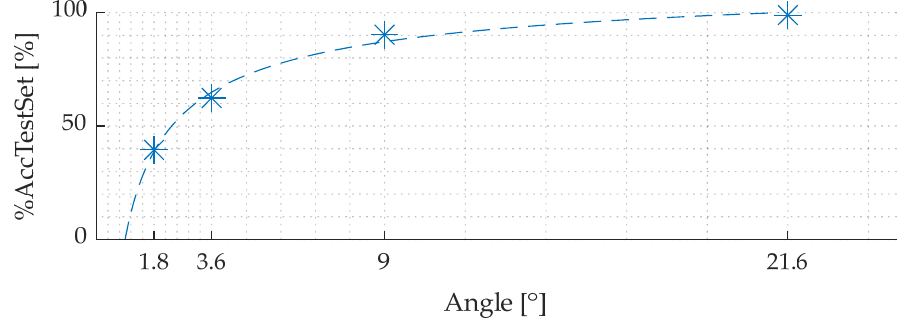
Figure 8. Values of the accuracy %AccTestSet depicted with blue star mark with approximation function (blue dash line) versus rotation step angle size.